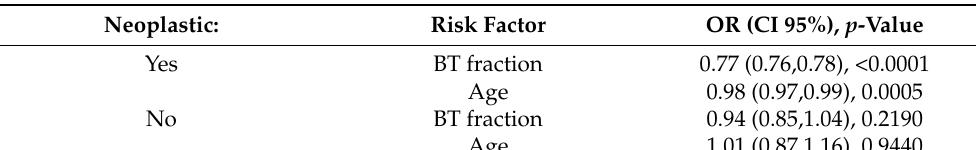
Table 5. The influence of BT fractions and available risk factors on ranked Tognetti’s clinical (23) and Lallas/Tognetti’s dermoscopic (8) features of BCCs.